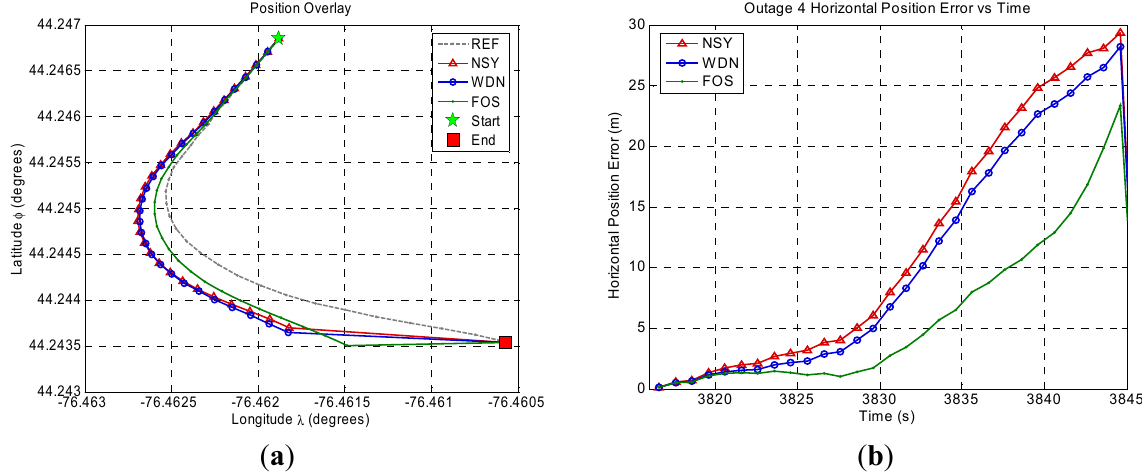
Figure 11. Land vehicle experiment position domain results for GPS outage 4. ( a ) Position domain plot. ( b ) Horizontal position error